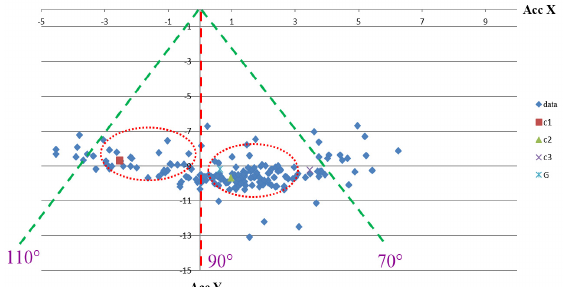
Figure 6. Detected angles affected by gravity at different swing velocities. Note that Acc X (unit: g) and Acc Y (unit: g) represent the measured acceleration from x- and y-direction of the accelerometer, respectively.